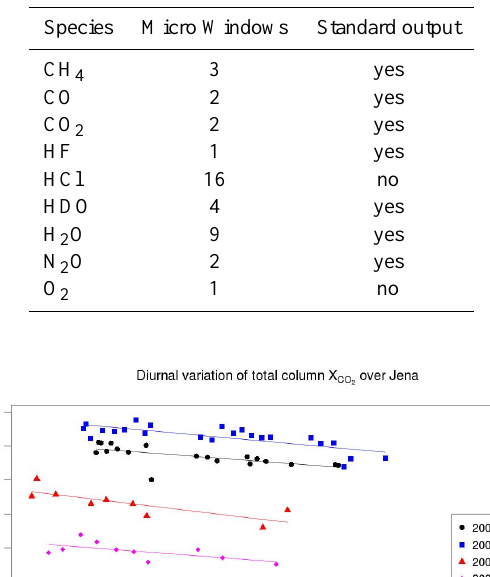
Table 3. Table of species retrieved from GFIT and the associated number of analyzed micro windows according to TCCON specifi- cations.